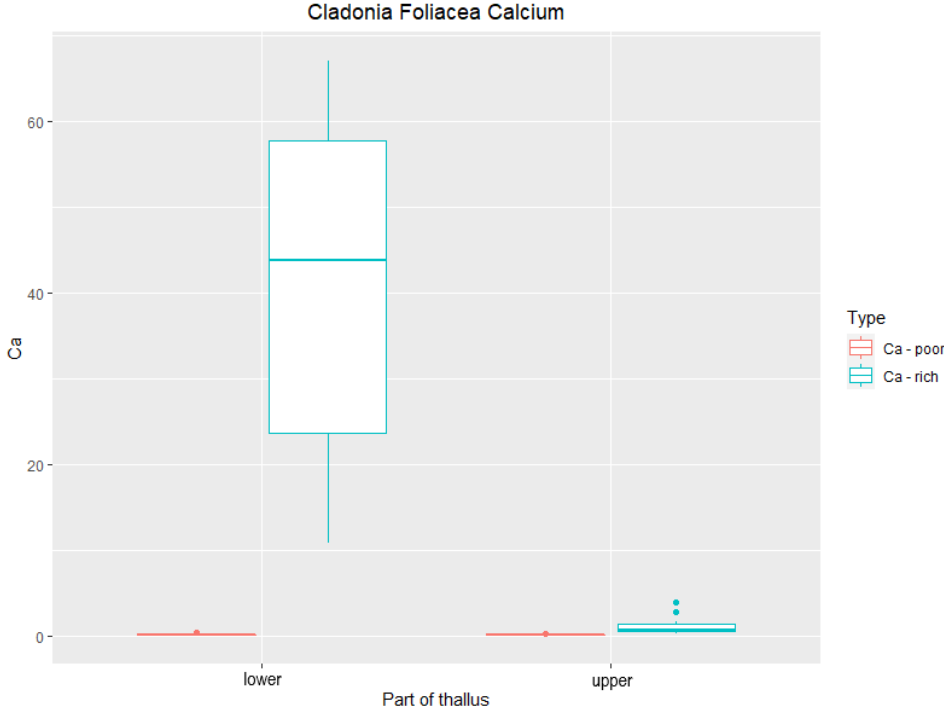
Figure 5. Content of Ca (DW%) in lichen Cladonia foliacea collected from calcium-rich and calcium- poor sites ( n = 5). “Upper” and “lower” designate the location of the measured area.